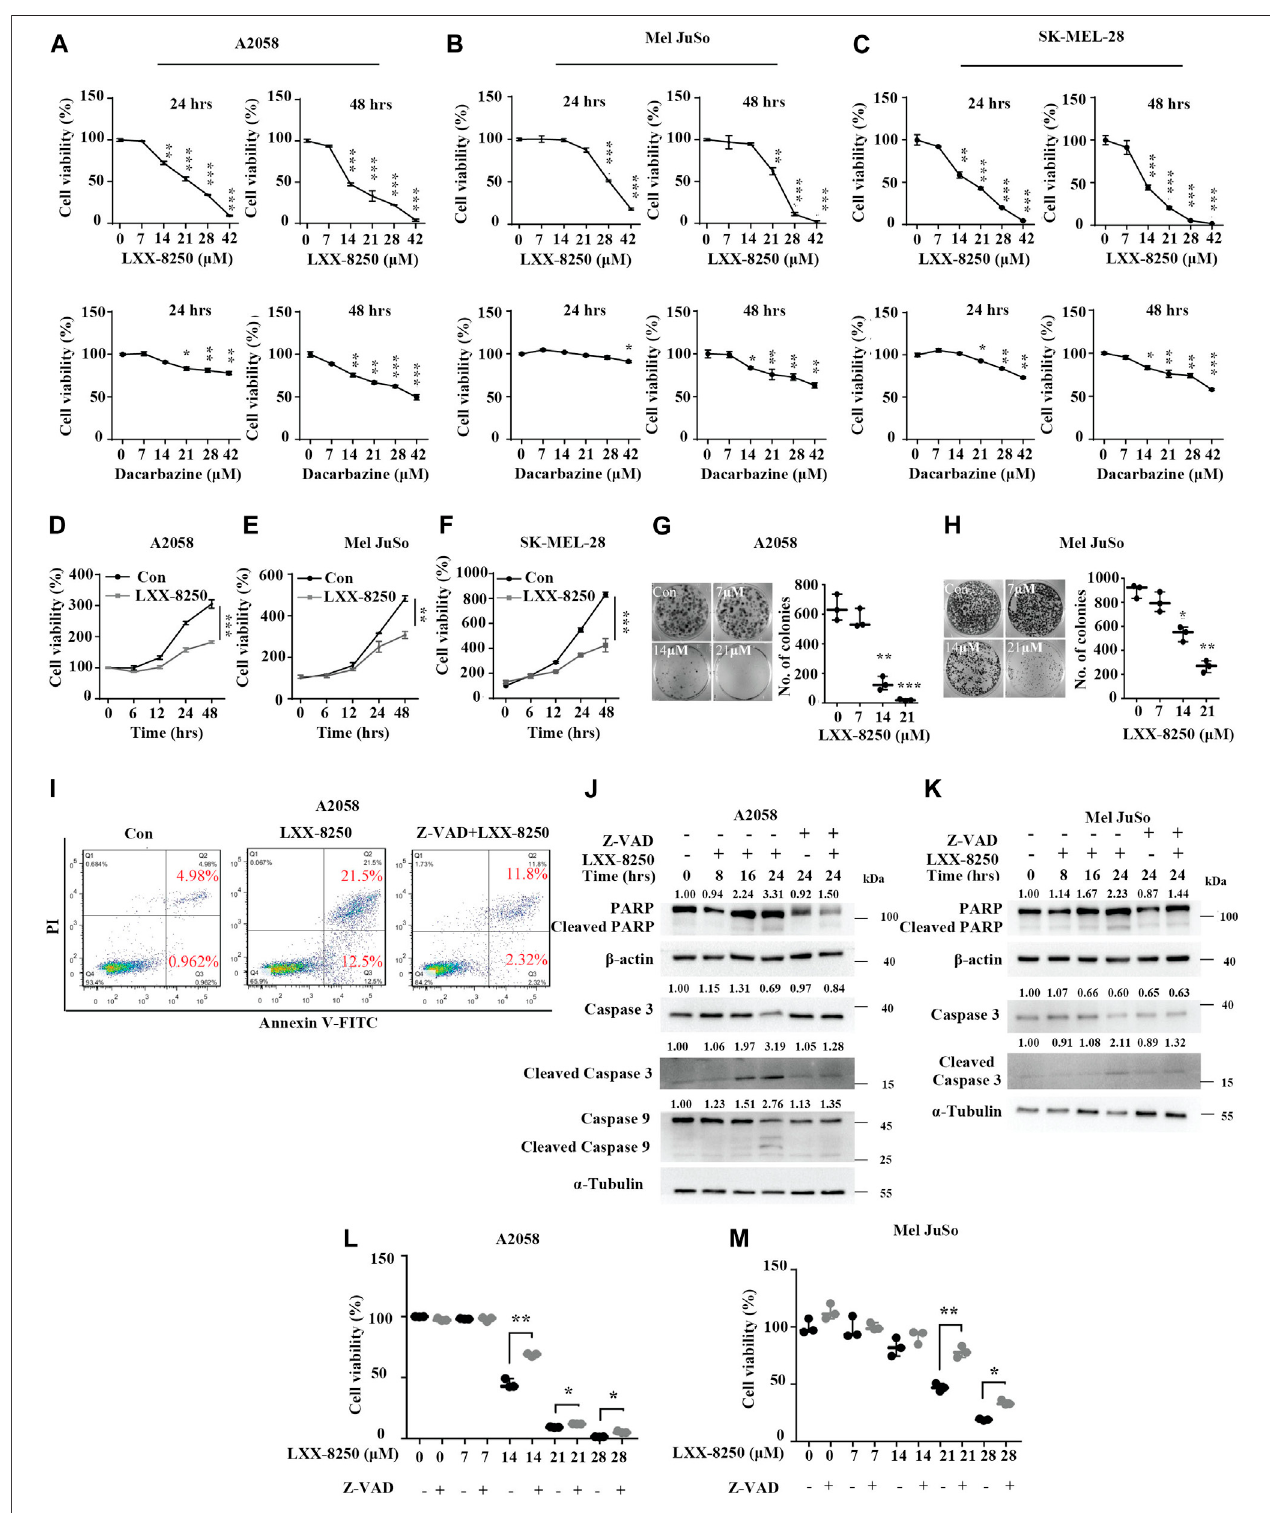
FIGURE 1 | Effects of LXX-8250 on melanoma cells. (A – F) Cell viability assays in A2058 (A,D) , Mel JuSo (B,E) or SK-MEL-28 (C,F) cells. Cells were treated with increasing concentration of LXX-8250 or Dacarbazine for the indicated time (A – C) , or at 14.6 µM (D) , 22.8 µM (E) or 13.5 µM (F) respectively for increasing time. (G,H) ColonyformationassaysinA2058 (G) orMelJuSo (H) cellstreatedwithLXX-8250attheindicatedconcentration. (I) Apoptosisassaysinthecellstreatedwithout(Con)orwith